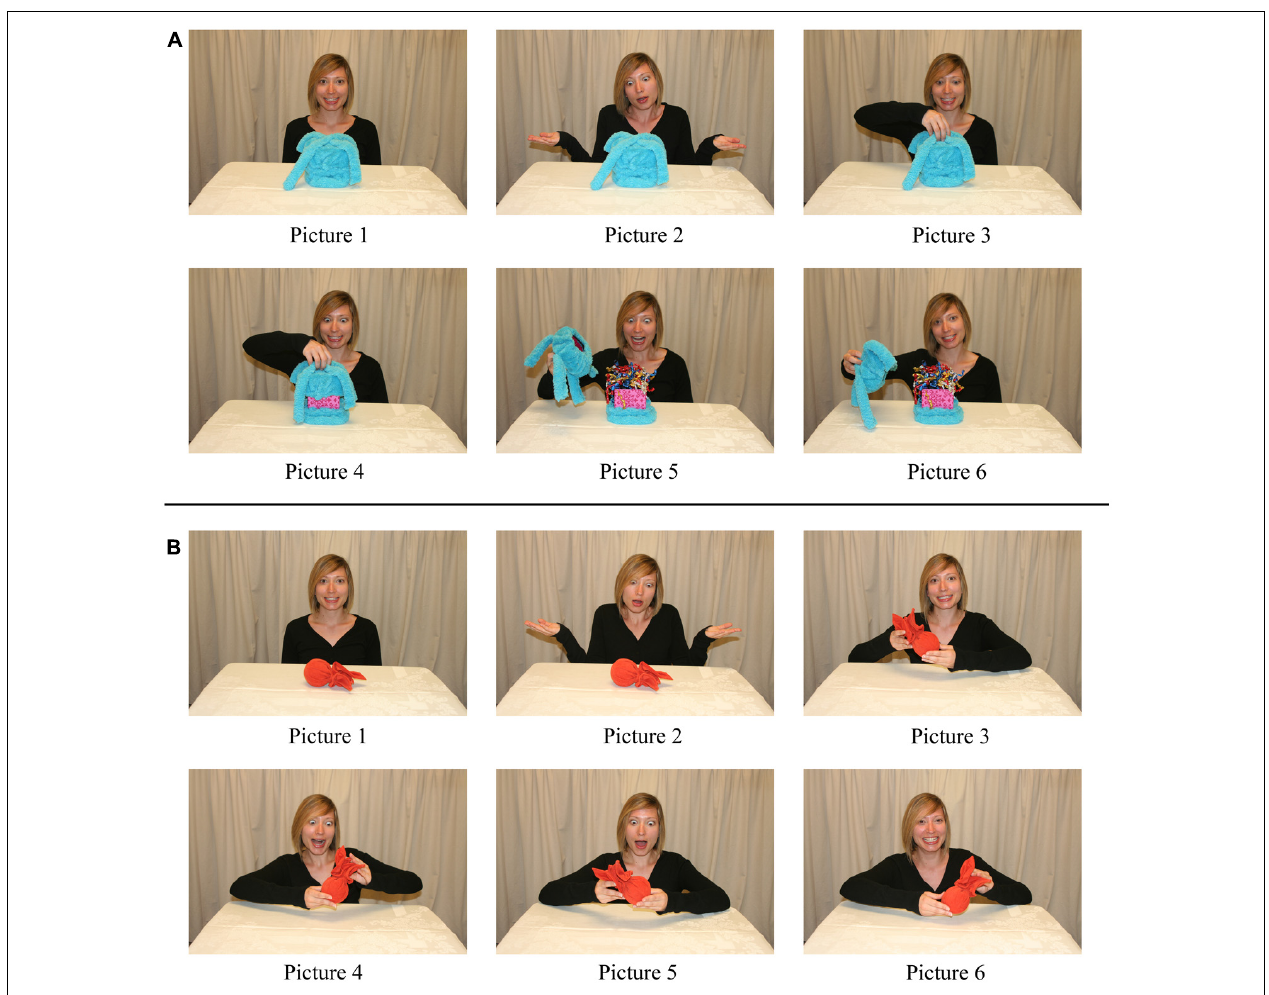
FIGURE 3 | Sequence of pictures used in the non-obvious property phase. (A) The target object of the box object set. (B) The non-target object of the box object set. Adapted from Keates etal. (in press).